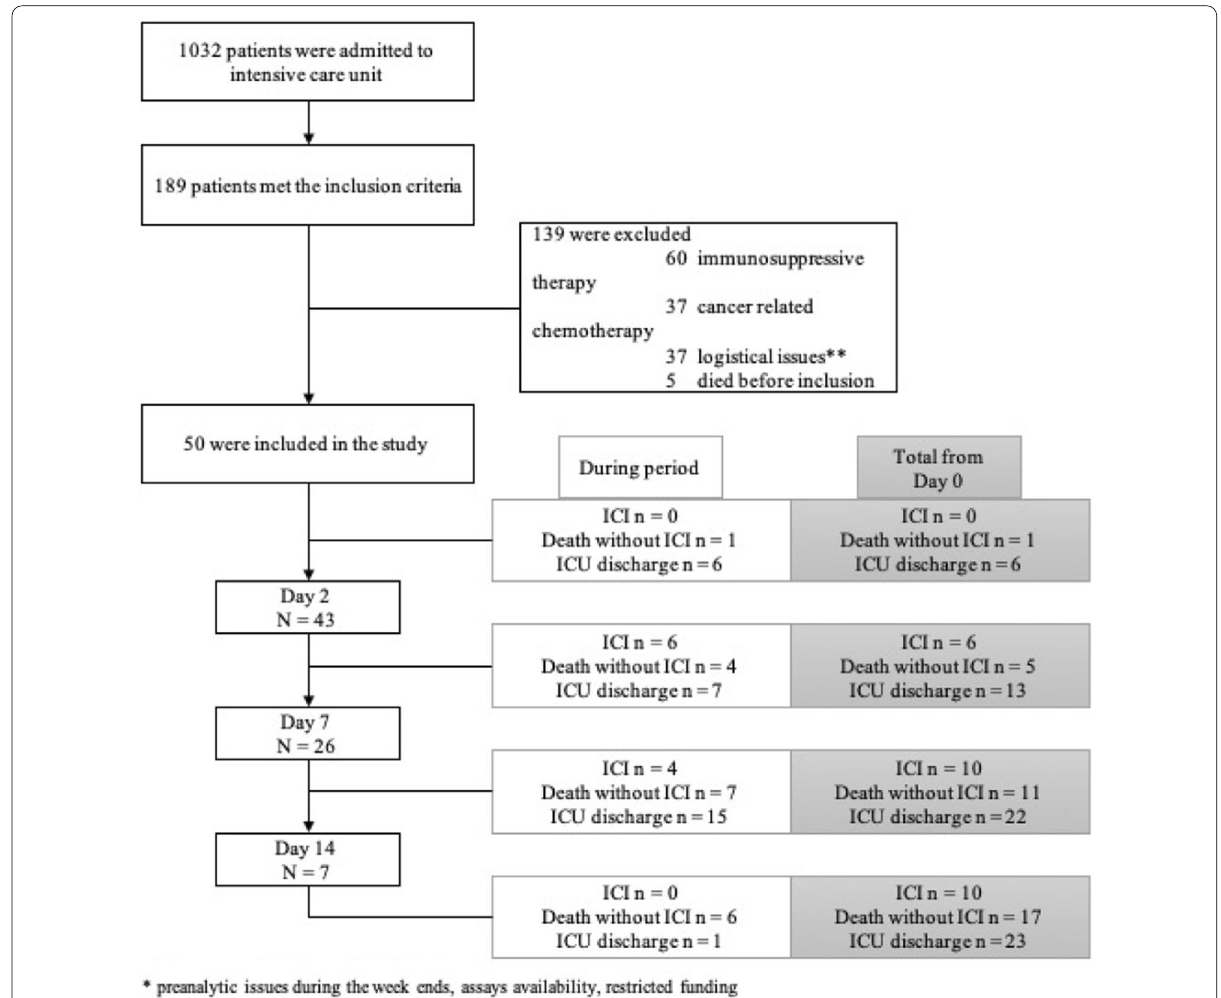
Fig. 1 Flowchart. IC Invasive Candida Infection, ICU intensive care